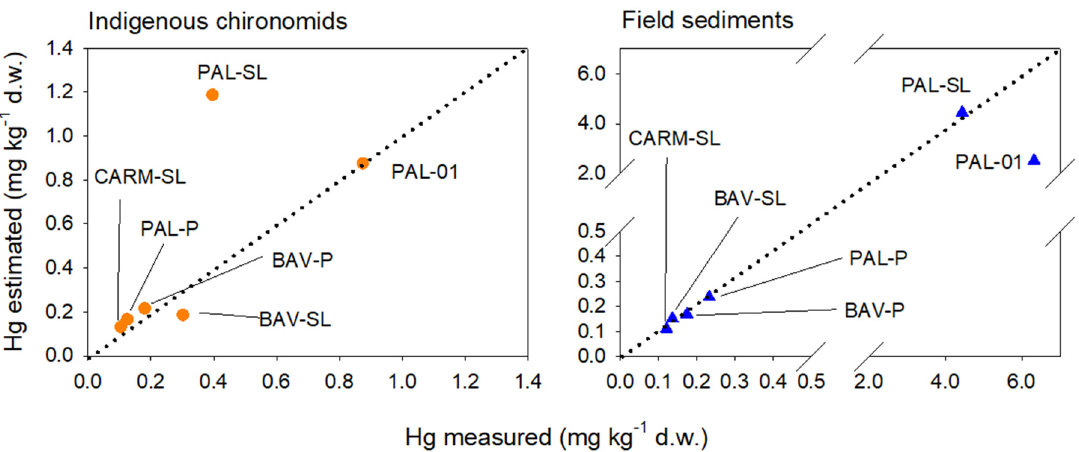
Figure 3. Scatterplot of measured vs. estimated Hg concentration values for ‘Indigenous chironomids’ and ‘Field sediments’. Estimated values were obtained using regressions 1 and 2 (see text) for chironomids and sediments, respectively. The dashed lines indicate the ideal 1:1 correspondence.